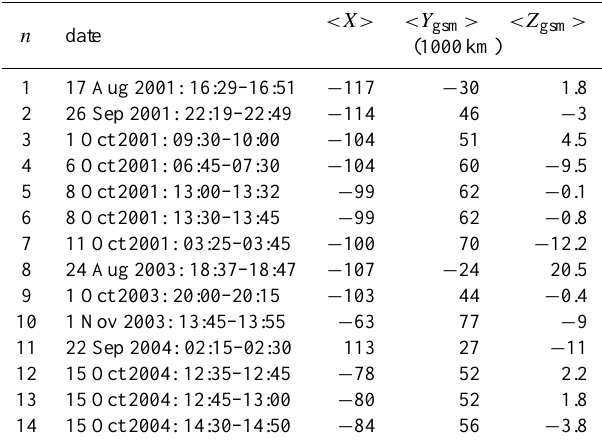
Table 1. Fourteen events with fast monochromatic flapping mo-